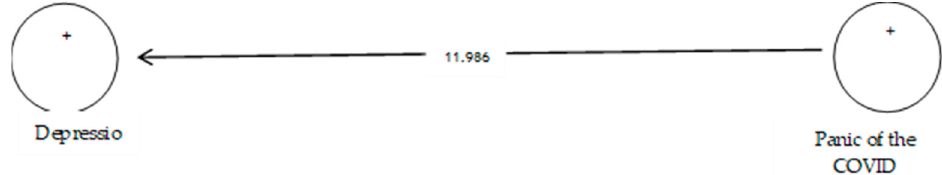
Figure 21. Drawn model with significant coefficients z. Table 13. Evaluation indicators of the internal model of the research, direction and significance of direct effects.